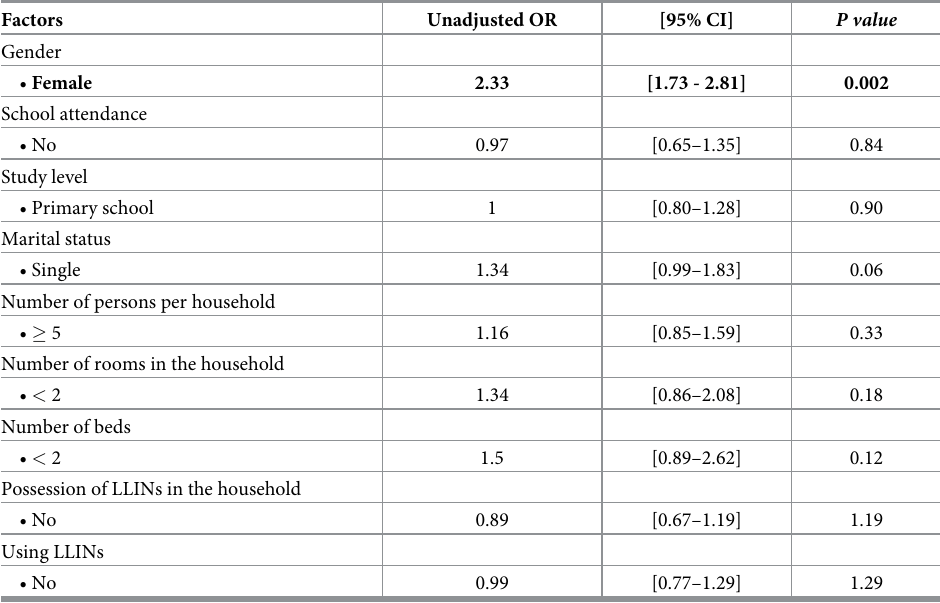
Table 4. Relationship between Plasmodium spp infection and various socio-demographic factors, using bivariate analysis (unadjusted odds ratios). Factors